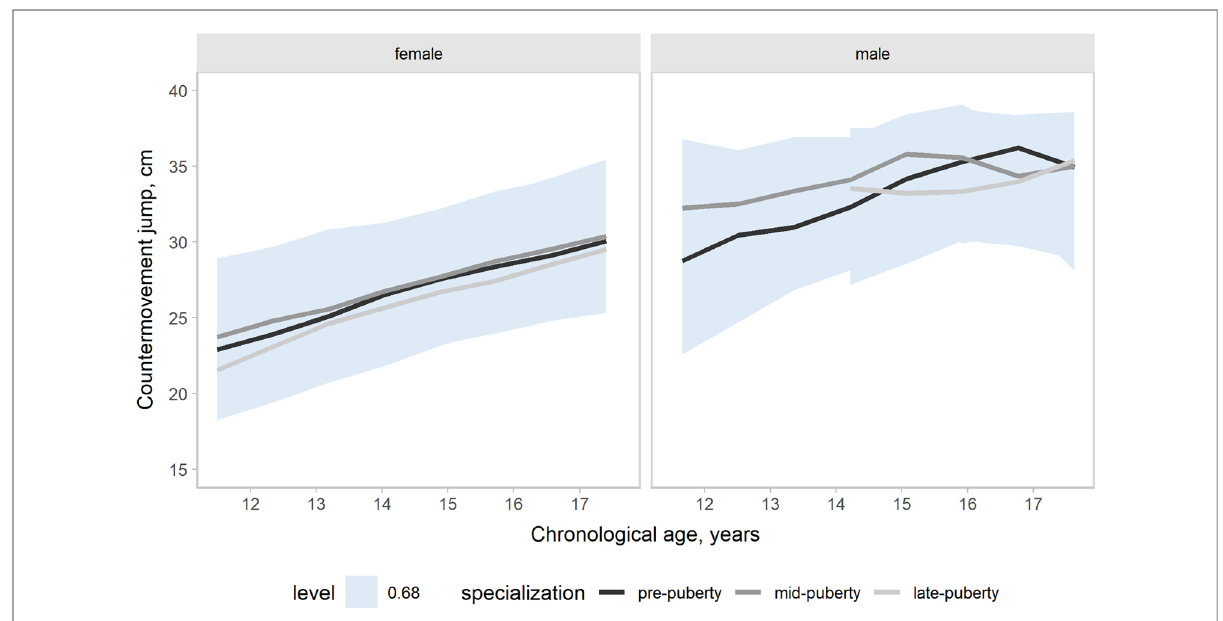
FIGURE 5 Developmental changes in countermovement jump performance for young females and male basketball players by specialization onset. The shaded area represents the 68% credible interval, similar to a standard